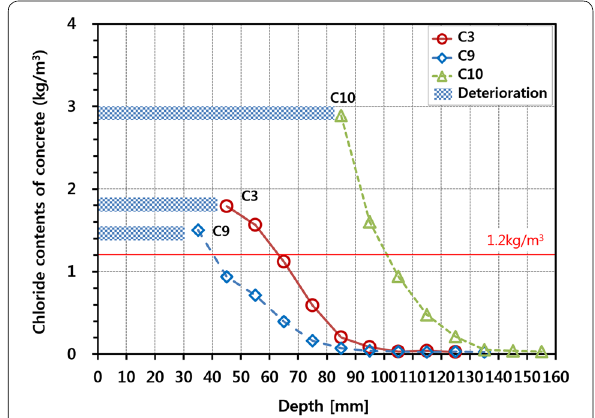
Fig. 7 Analysis result of chloride contents of concrete by depth.